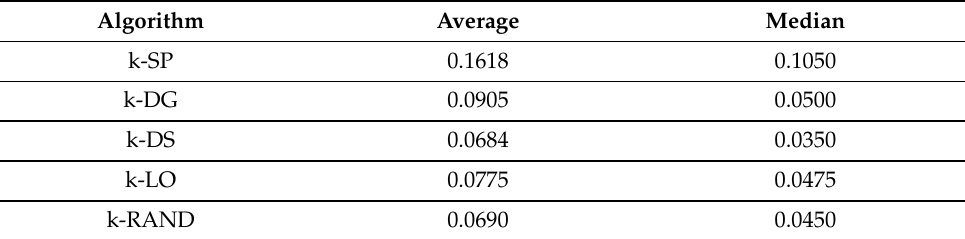
Figure 4. Histogram plot of the attackers’ detectability/MaxUp of launching a DDoS Attack on an LEO satellite network. Table 3. MaxUp